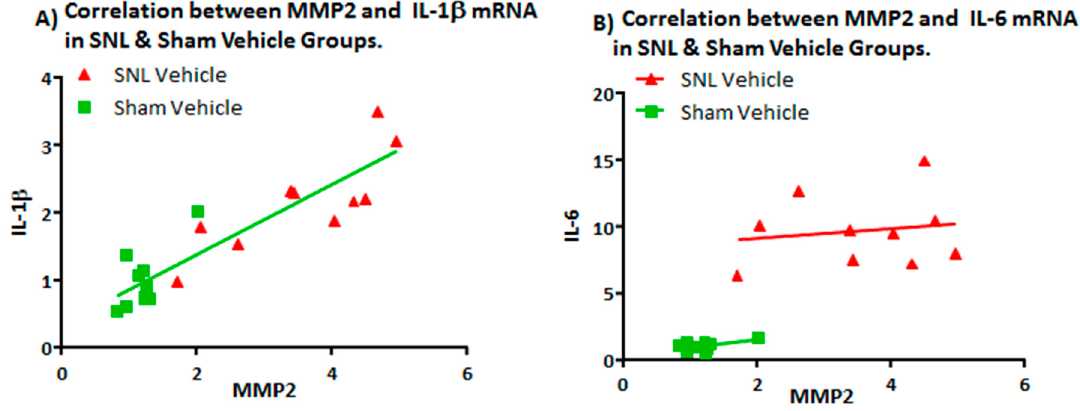
Figure 4. IL-1 β ( A ) and IL-6 ( B ) mRNA expression levels in ipsilateral DRG for sham and SNL vehicle groups. Both IL-1 β and IL-6 mRNA expression levels were found to be significantly elevated after SNL-surgery in vehicle group compared to sham. Data presented as the average from n = 10 per group ± SEM and analyzed a with two-tailed unpaired t-test. (***, p < 0.001; ****, p < 0.0001).